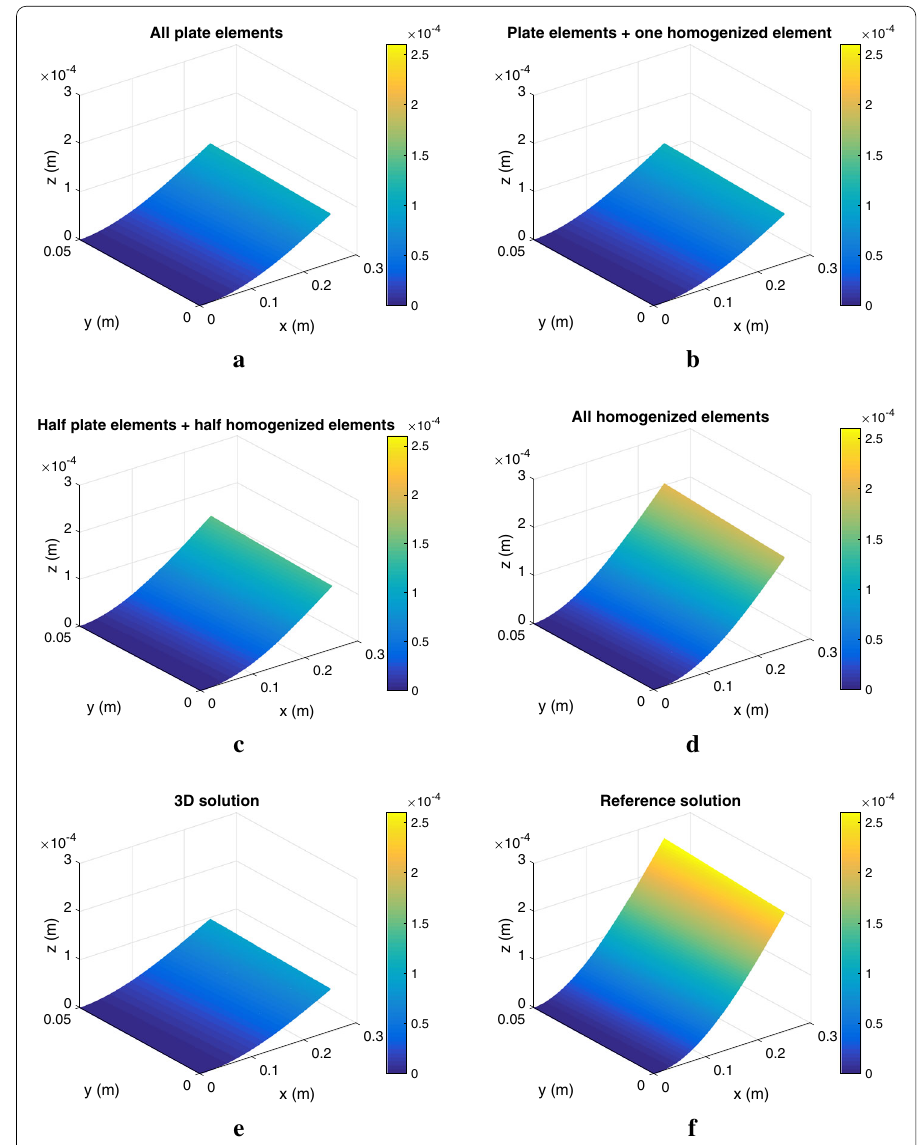
Fig. 6 Displacement of the plate middle plane using plate theory ( a ), all plate theory elements except the homogenized (enriched) element ( b ), half plate theory elements (the triangles of the mesh in Fig. 2 with the right angle on the bottom) and half homogenized (enriched) elements (the triangles of the mesh in Fig. 2 with the right angle on the top) ( c ), all homogenized (enriched) elements ( d ), fully 3D FEM on a coarse mesh ( e ), fully 3D FEM on fine mesh ( f )